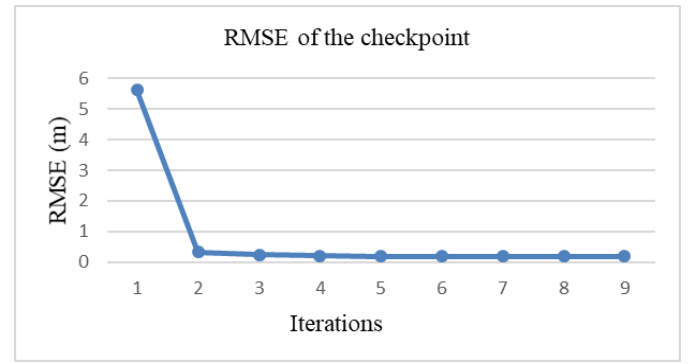
Figure 8. RMSE of checkpoint during adjustment iteration.